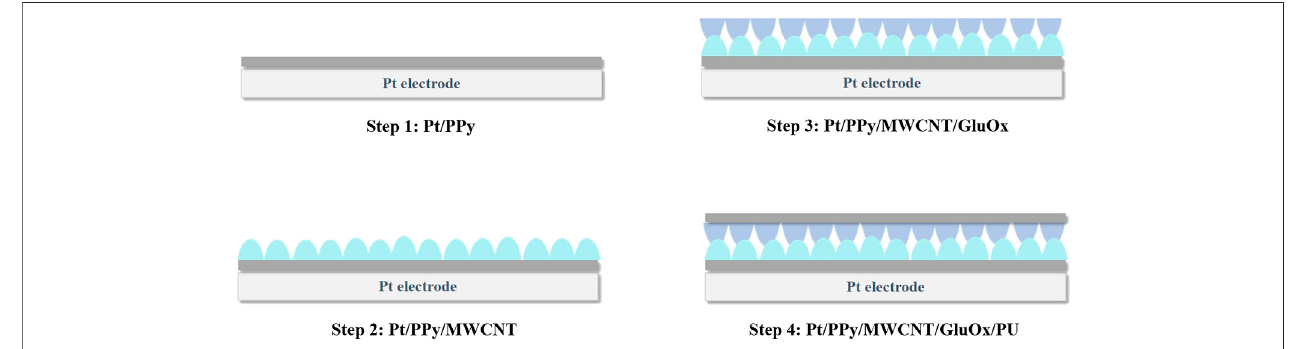
FIGURE 2 | Schematic representation of the glutamate sensor